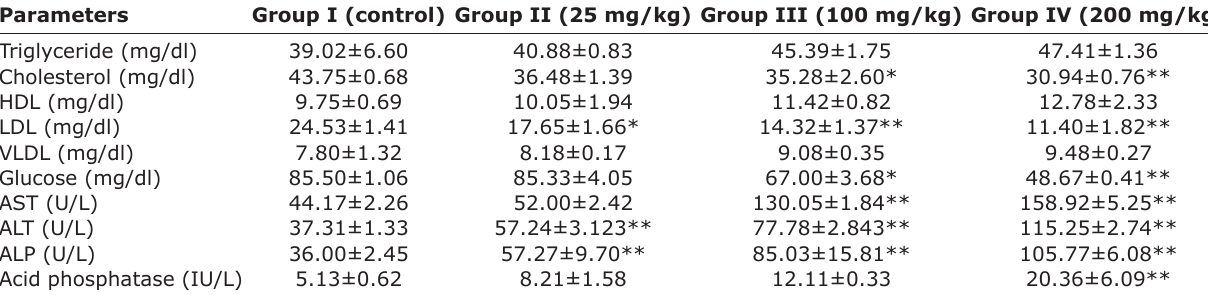
Table-1: Effect of acetamipirid on plasma level of different analytes after sub-acute exposure. Parameters